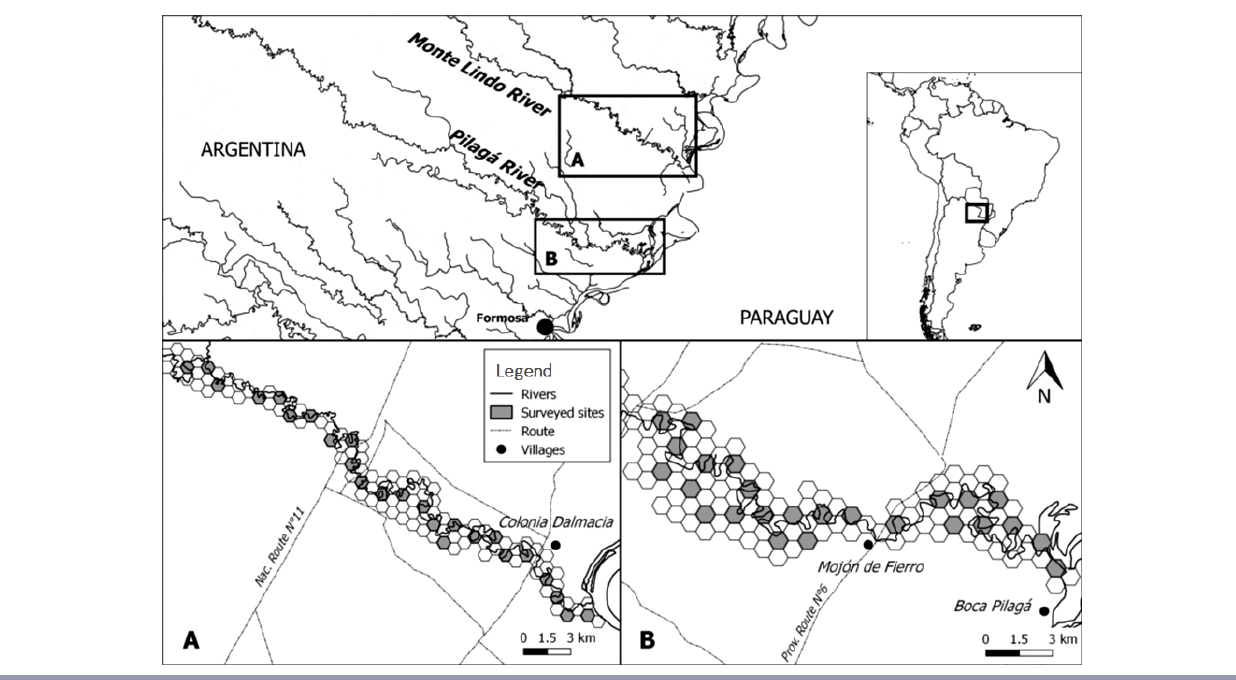
Fig. 1 . Location of the study areas along the gallery forests of the Monte Lindo and Pilagá Rivers in the Humid Chaco, northern Argentina. Gray hexagons represent the 48 sites